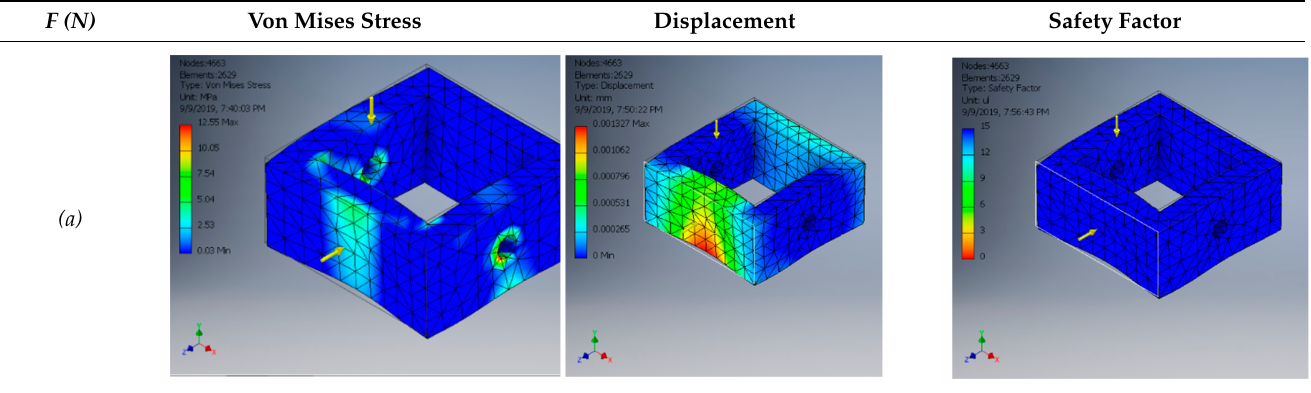
Table 8. Von Mises stress, displacement and safety factor for the slider when applying loads of (a) 536.61 N, (b) 598.41 N, (c) 622.94 N and (d) 697.49